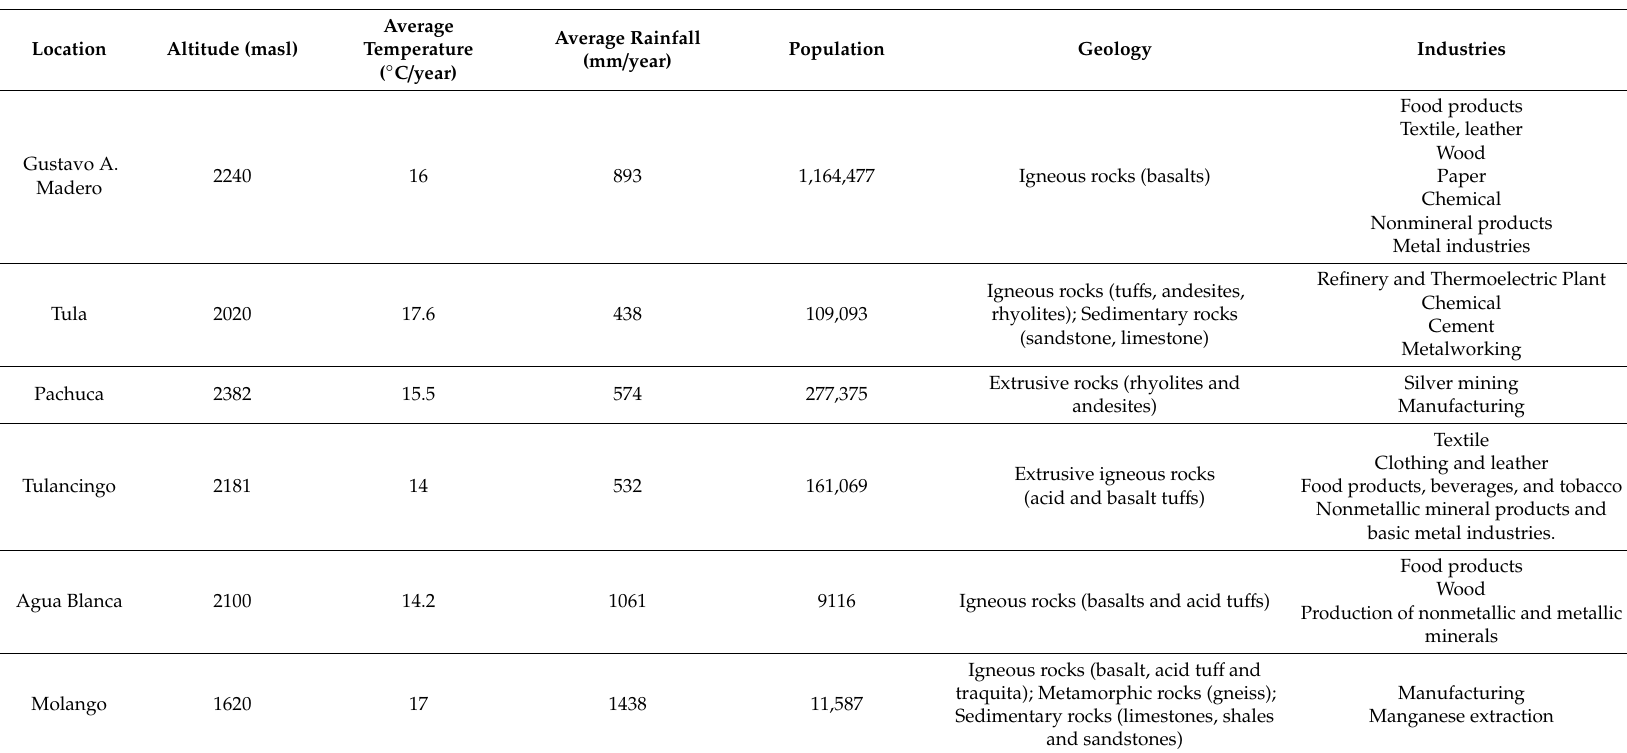
Table 1. Description of the study